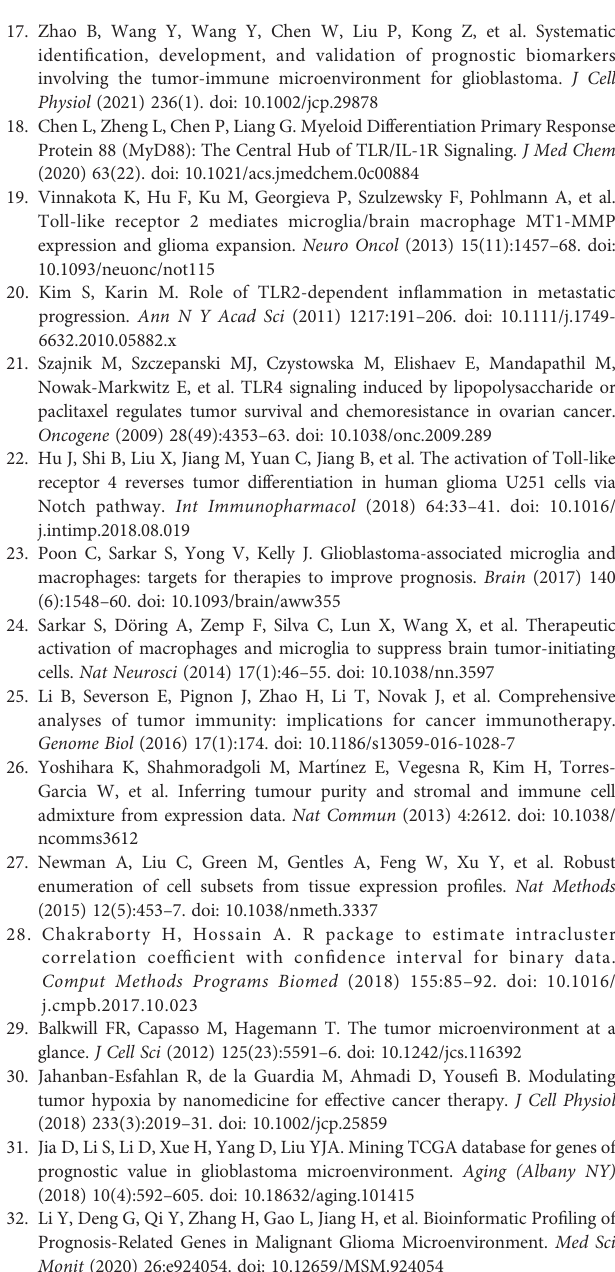
Supplementary Table 1 | The clinicopathological characteristics of glioma patients from TCGA. Supplementary Figure 1 | The analysis procedures of this study. Supplementary Figure 2 | MYD88 expression was associated with the IDH mutant status, age and WHO grade in CGGA database. (A) MYD88 expression increased with the WHO grade. (B) IDH 1 mutant status was associated with lower MYD88 expression. (C) MYD88 expression mainly manifested signi fi cantly lower in WHO III and WHO IV grade IDH 1 mutant patients. Supplementary Figure 3 | The MYD88 gene methylation decreased signi fi cantly with the WHO